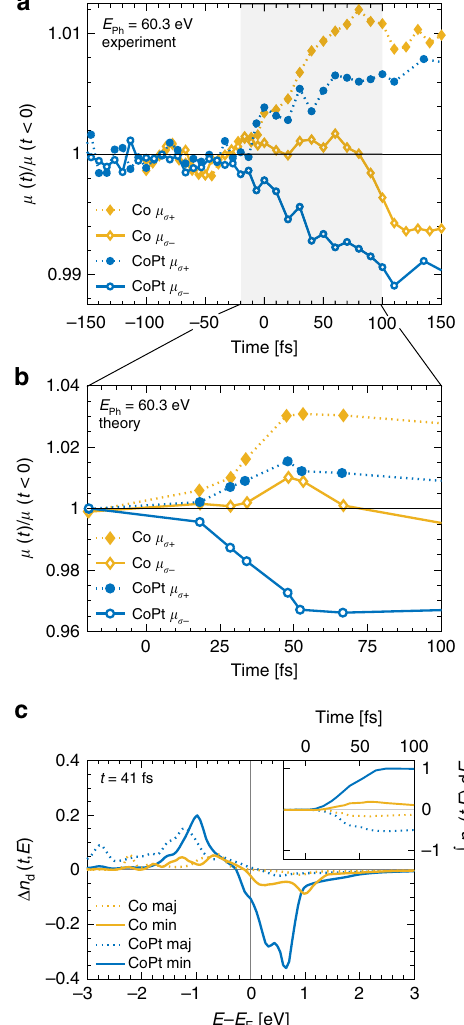
Fig. 3 Helicity-dependent transient absorption and corresponding evolution of the density of states. a Experimentally measured and b theoretically calculated normalized helicity dependent absorption, µ σ ± , for the Co and CoPt sample at the Co M 2,3 resonance at 60.3 eV as a function of pump-probe delay. We interpret the qualitative difference of the response of µ σ − between the single and two-component samples as an ef fi cient fi lling of available minority states above the Fermi level, E F , in CoPt. Note the excellent agreement between experiment and theory. c The calculated difference of occupied minority and majority d -states, Δ n ( t = 41 fs, E ) after optical excitation for Co and CoPt. Laser excitation leads to an increase of available states, Δ n ( t, E ), below, and a decrease above E F , the latter being strongly enhanced for CoPt. The inset compares the energy- integrated occupied Co d -states, n d , for the Co and CoPt samples. It clearly shows that in CoPt, the increase of minority electrons exceeds the loss of majority electrons. This is explained by OISTR transferring minority electrons from Pt to